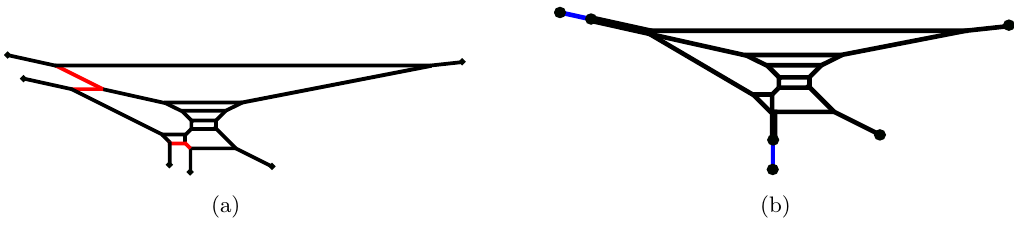
(cid:0) SU(3) 0 quiver theory. (b) The diagram 2